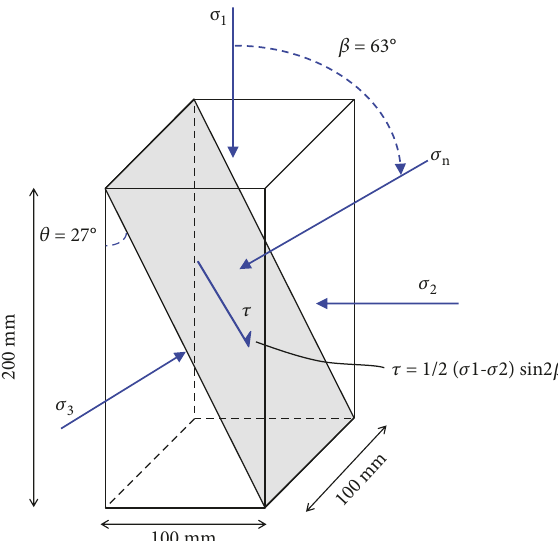
Figure 9: Shear stresses and shear displacement calculated from the applied major principal stress and intermediate principal